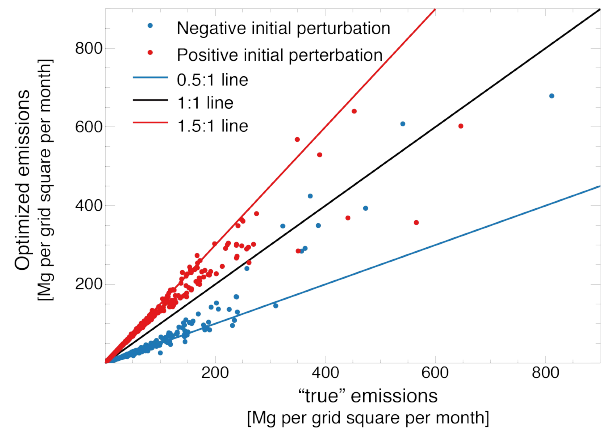
Fig. 9. Scatterplot of optimized vs. “true” methane emissions for individual 4 ◦ × 5 ◦ grid squares. Blue and red points show emissions with negative and positive a priori perturbations, respectively. The a priori perturbations correspond to the blue and red